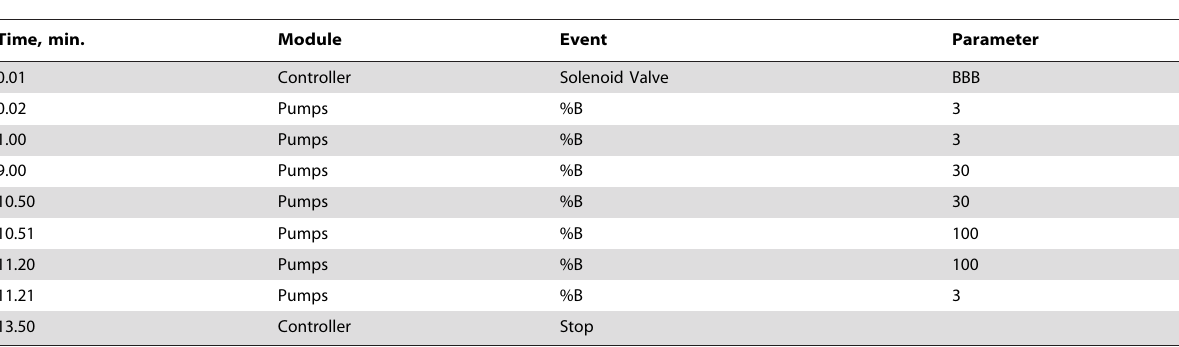
Table 2. HPLC Gradient Elution Table.